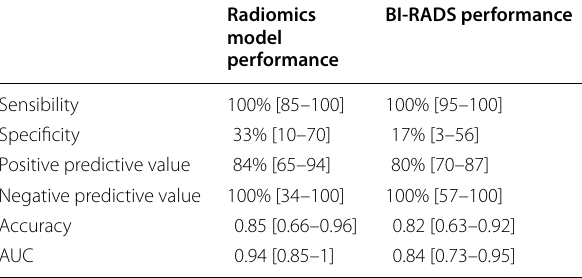
Table 3 Diagnostic performances of the radiomic predictive model and the BI-RADS analysis carried out by the radiologist